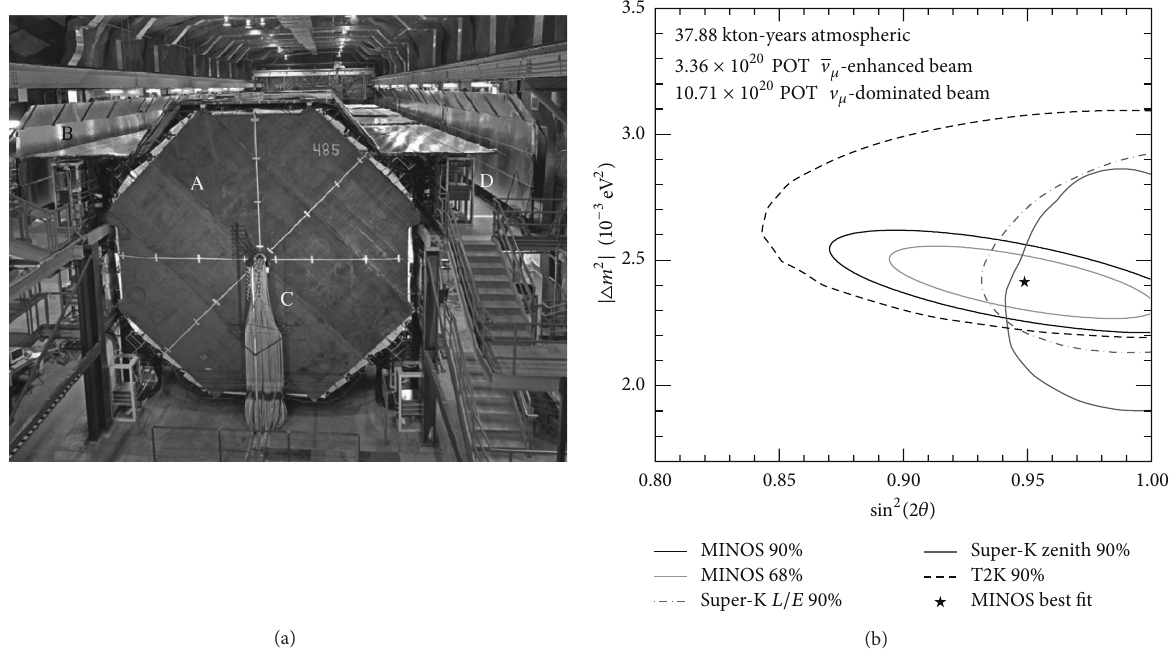
Figure 11: (a) Photograph of the MINOS far detector: “A” indicates the magnetized iron sheets, “C” is the electric coil, and “B” is an anticoincidence scintillator system. (b) Δ𝑚 2 23 versus sin 2 2𝜃 23 for ] 𝜇 oscillations measured by MINOS [104] and other experiments